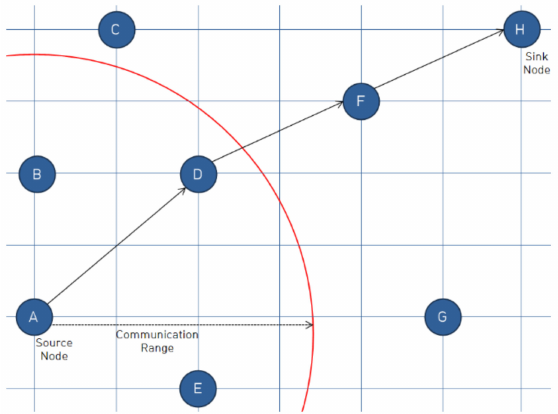
Figure 11. A WSN application for our experiment.